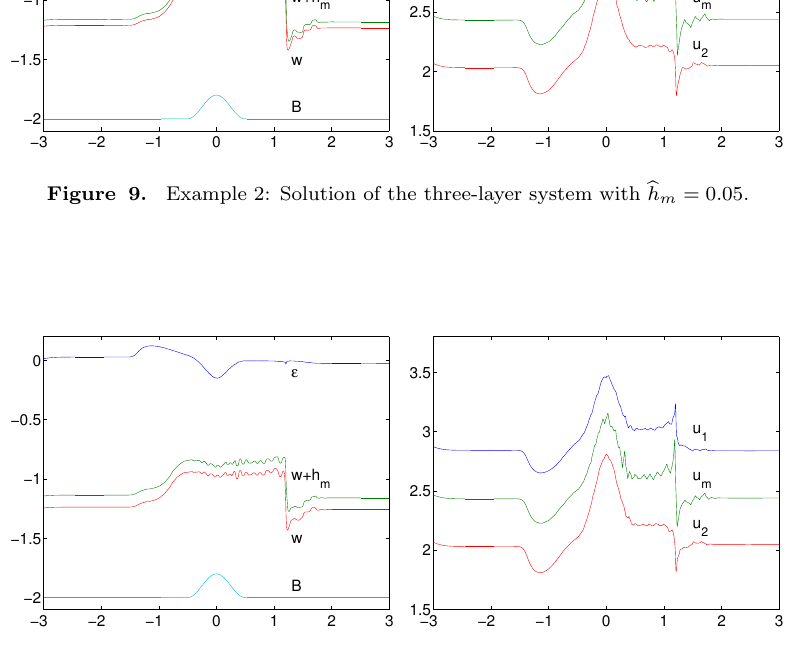
Figure 10. Example 2: Solution of the three-layer system with (cid:98) h m = 0 .